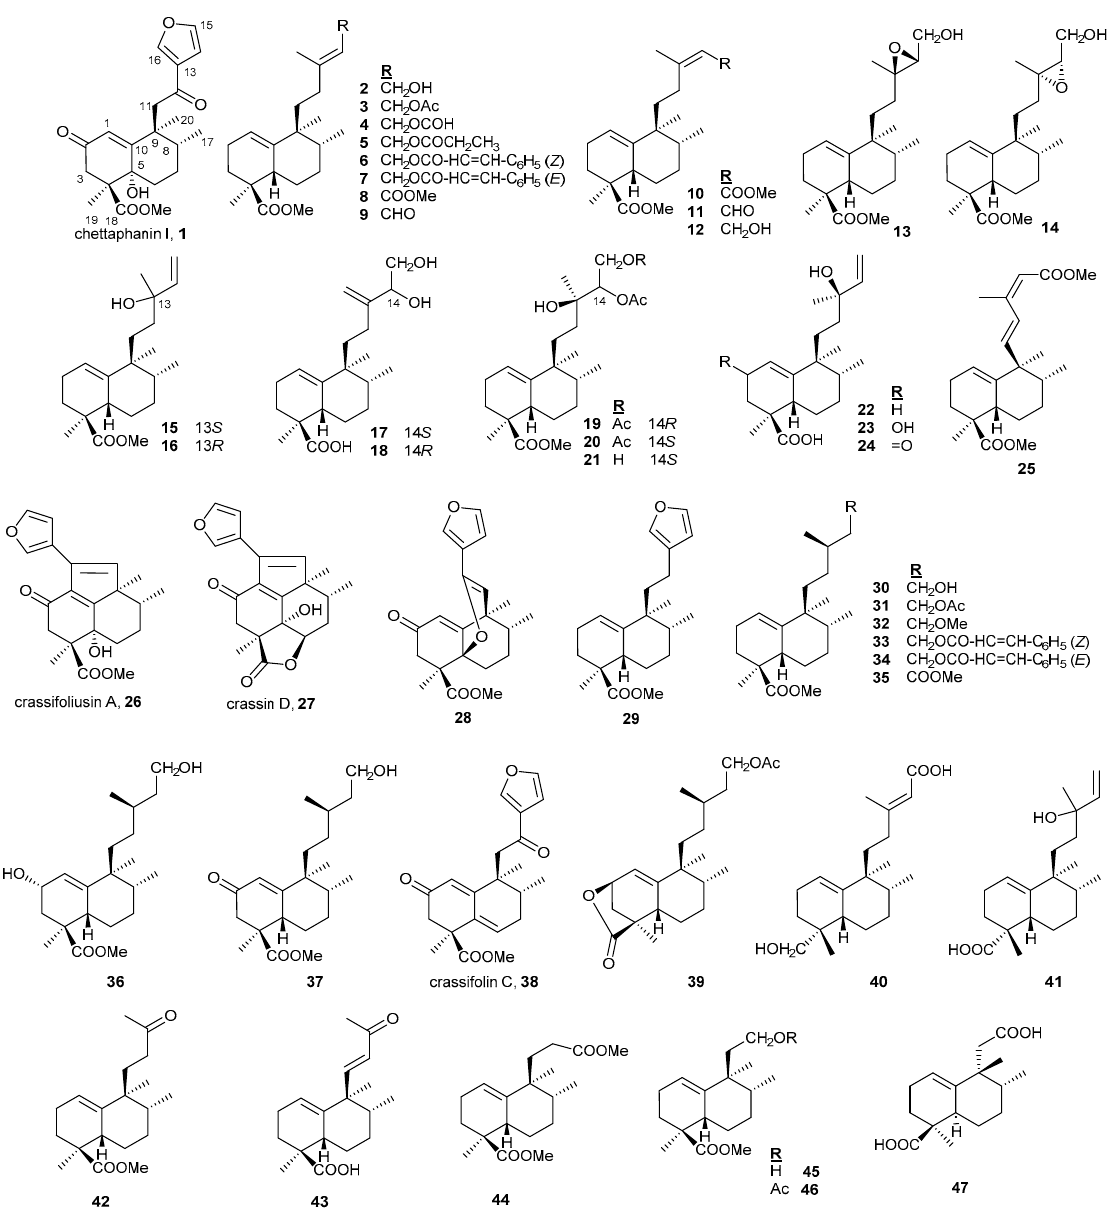
Figure 2. Halimane diterpenoids with the annular double bond in Ring A.